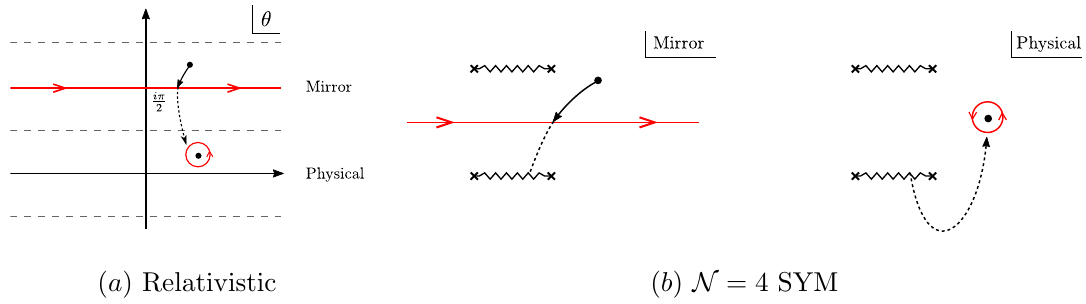
Figure 20 . The analytic continuation for the relativistic theories ( a ) and N = 4 SYM (b). In both cases, the red lines are the integration contours in the mirror channel. The poles cross the contour from above and end up in the physical